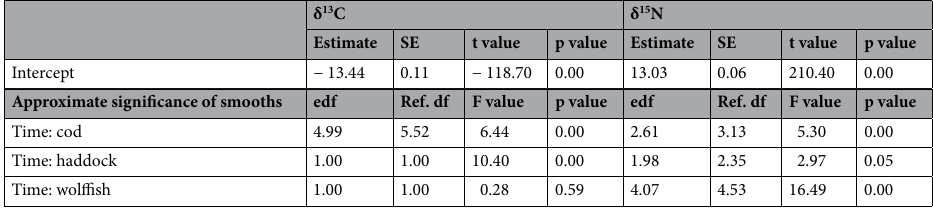
Table 2. Summary of results from the generalized additive models (GAMs).